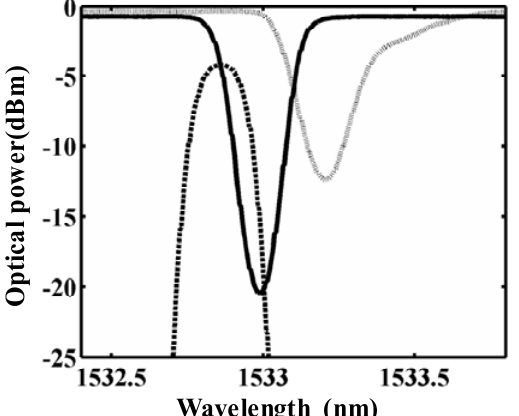
Figure 5. Measured optical spectra of three FBGs (Solid-line: FBG1; dotted-line: FBG2; dashed-line: